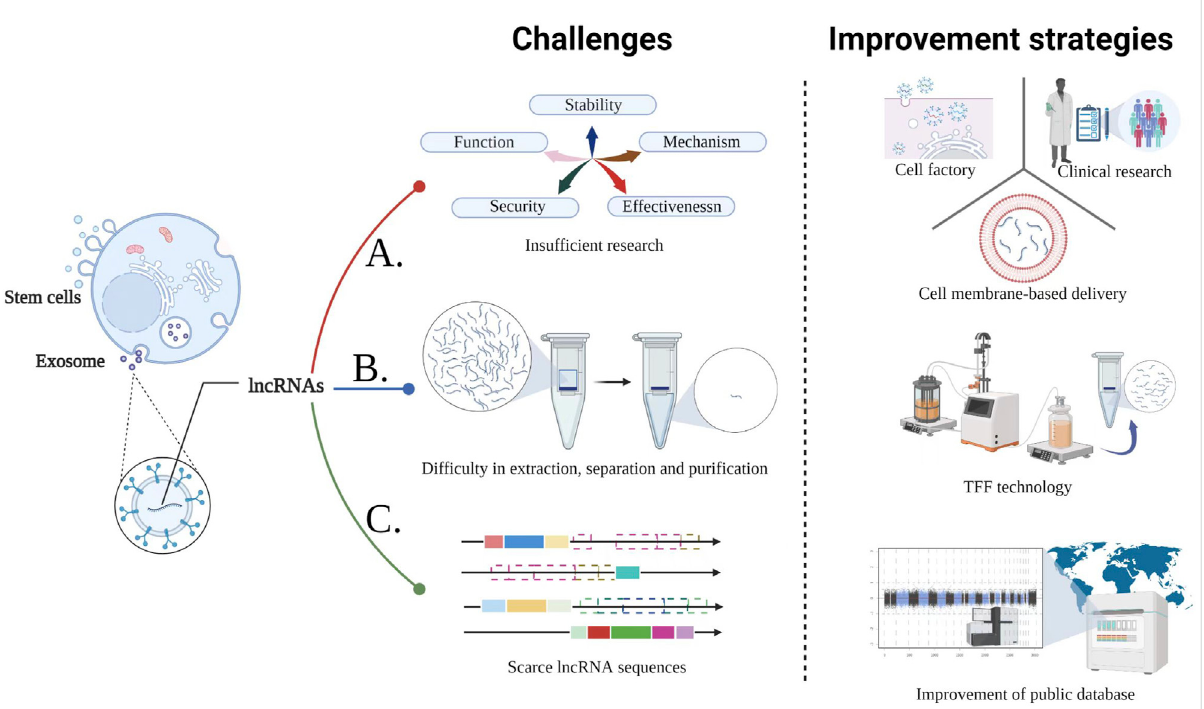
Challenges in the CVDs treatment with stem cell-derived Exo-lncRNA and the corresponding improvement strategies. A. The following three methods provide guidance for overcoming the de fi ciencies in studies related to the function, mechanism, stability, safety, and effectiveness of stem cell-derived Exo-lncRNA; B. TFF technology is ef fi cient for large-scale production of lncRNA; C. Eatablishing and improving public databases will assist in solving the limitations of scarce lncRNA sequences, reducing confusion and improving